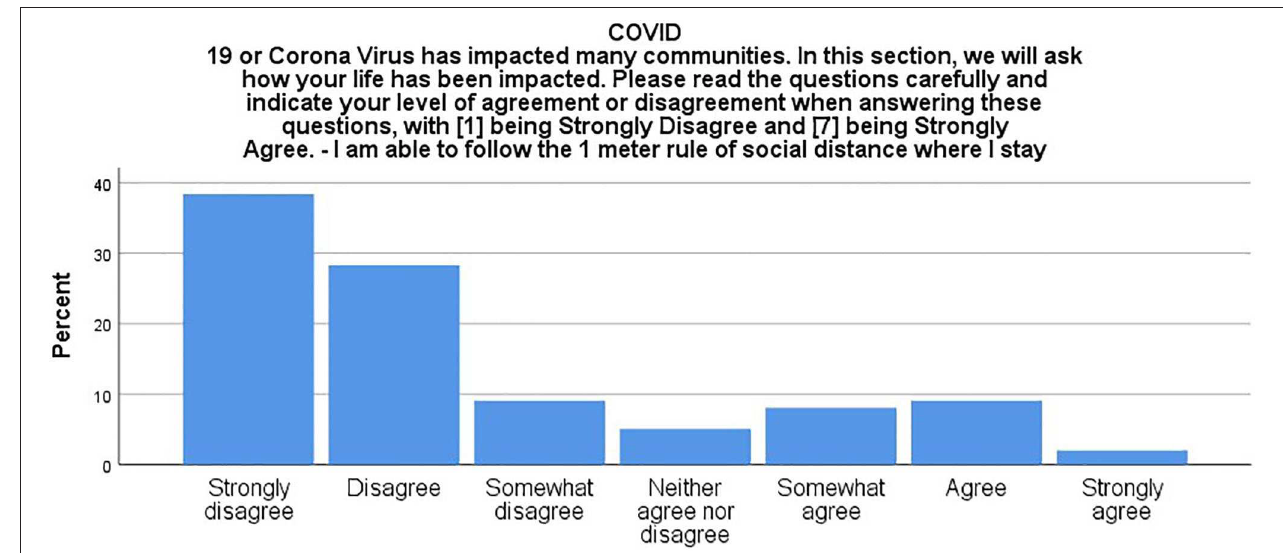
FIGURE 1 | Distribution of participants reporting their ability to follow one meter social distance rule.